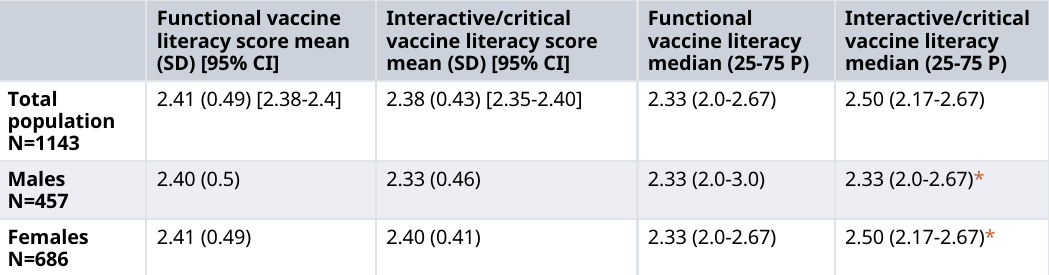
Table 5. Functionalvaccine literacy scores andinteractive/critical COVID-19vaccination literacyscores of the total population, men, and